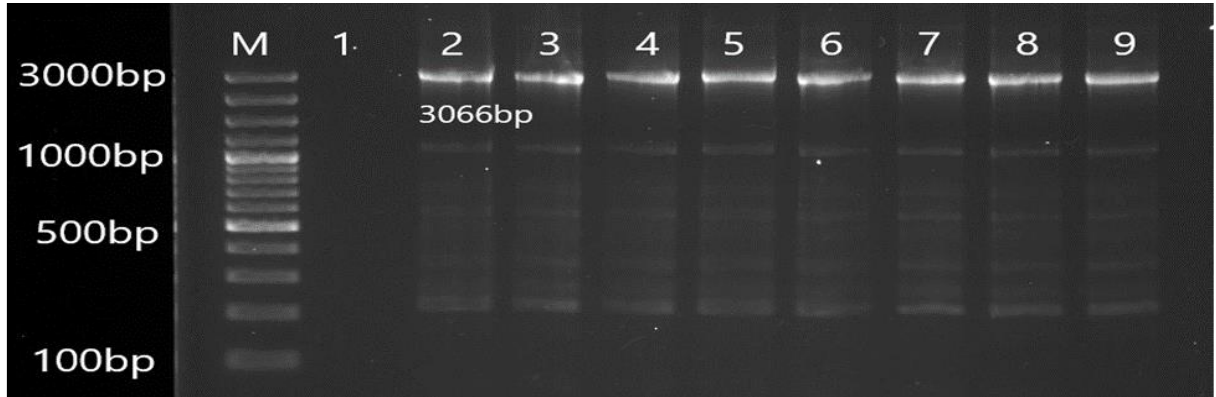
marker, Lane 1: Negative control, Lane 2 – 9: Positive isolates of oprM gene.